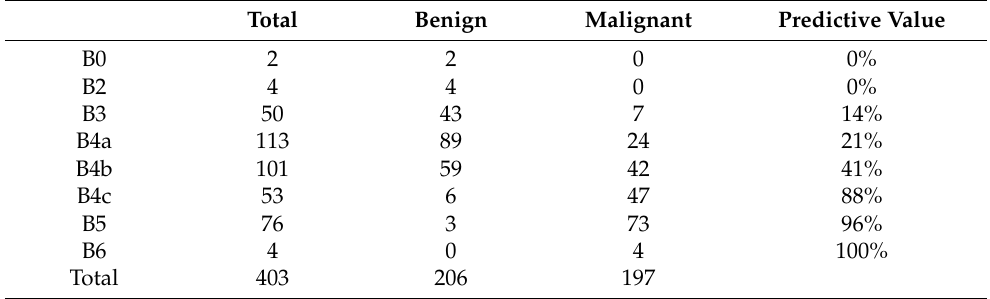
Table 1. BI-RADS.